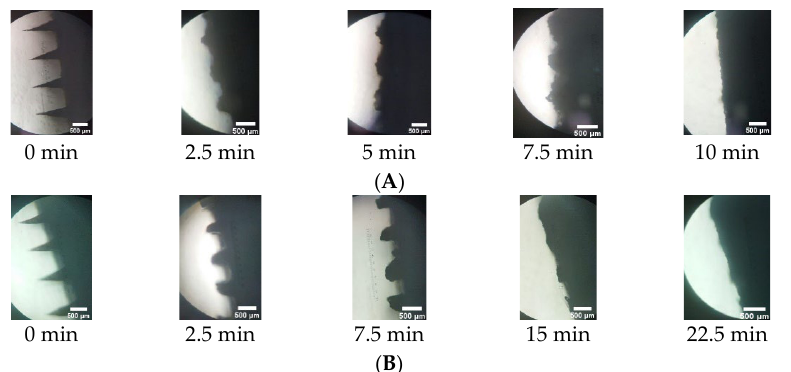
Figure 12. Microscopy observation for in-skin dissolution studies containing co-grinded ketoprofen in DMN formulations ( A ) F8-MN CG (5% PVA + 15% PVP) and ( B ) F11-MN CG (7.5% PVA + 15% PVP) (scale bar: 500 µm).